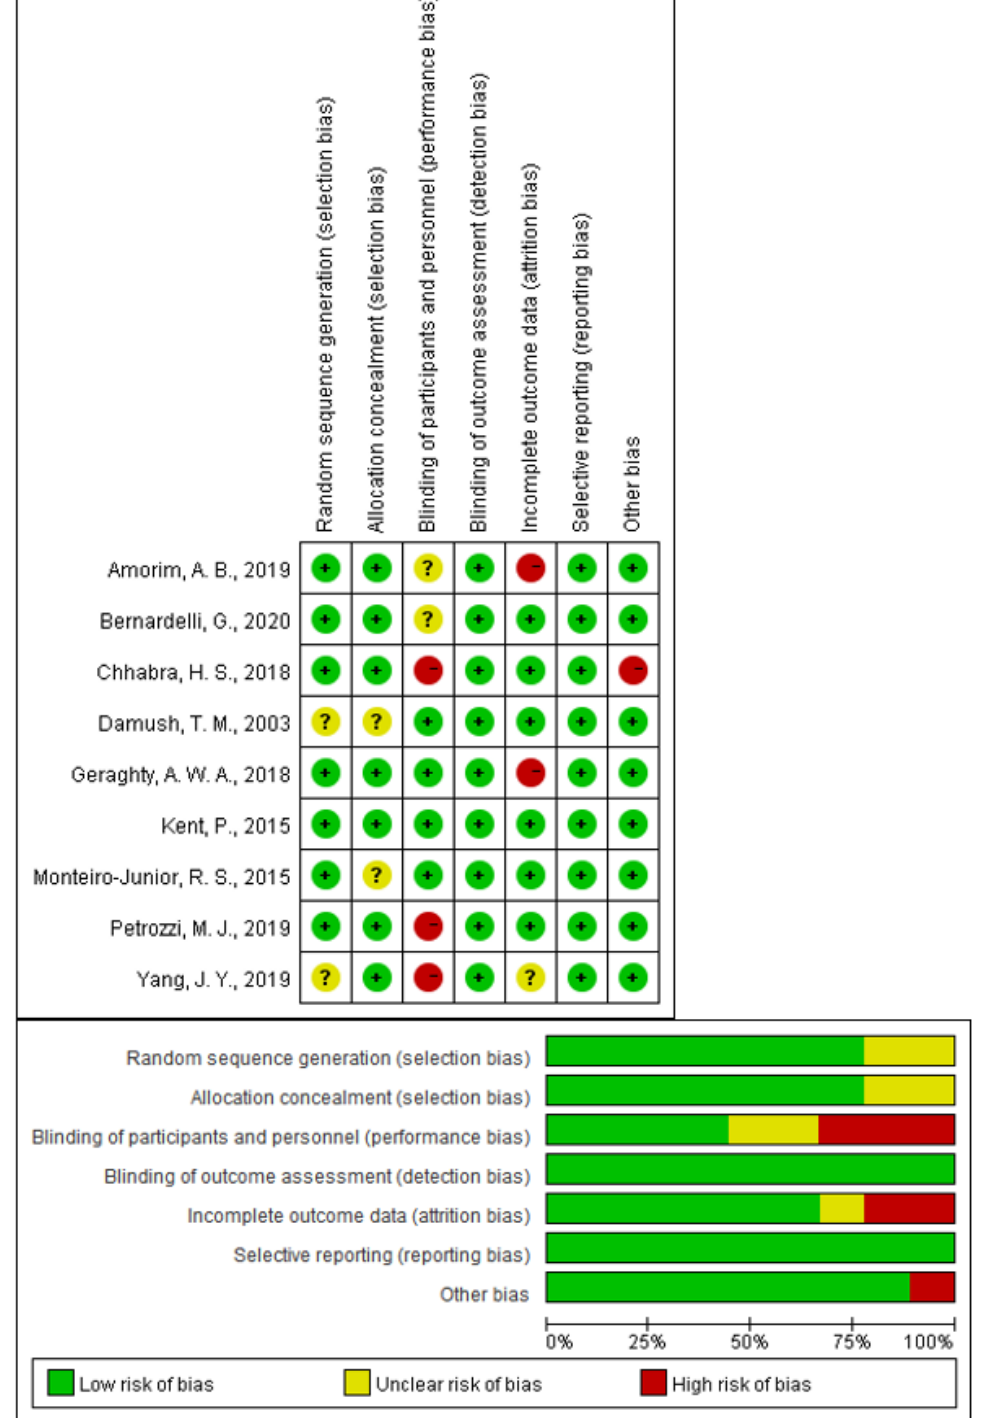
Figure 2. Risk assessment of bias in the included